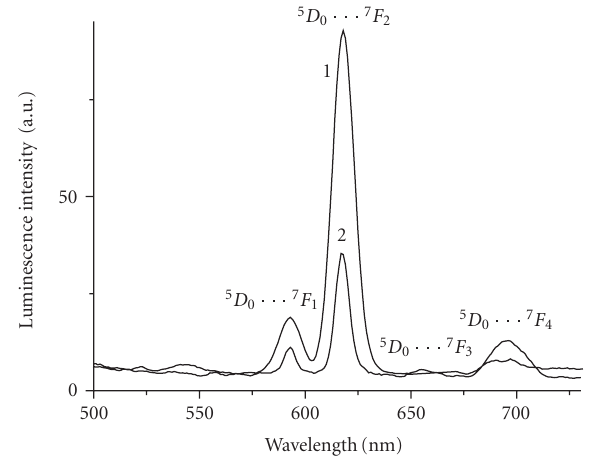
Figure 3: Luminescence emission spectra of 8 10 (cid:0) 5 M of (II) in (1) DMSO and (2) acetonitrile the presence of 2 (cid:0) at λ ex = 330